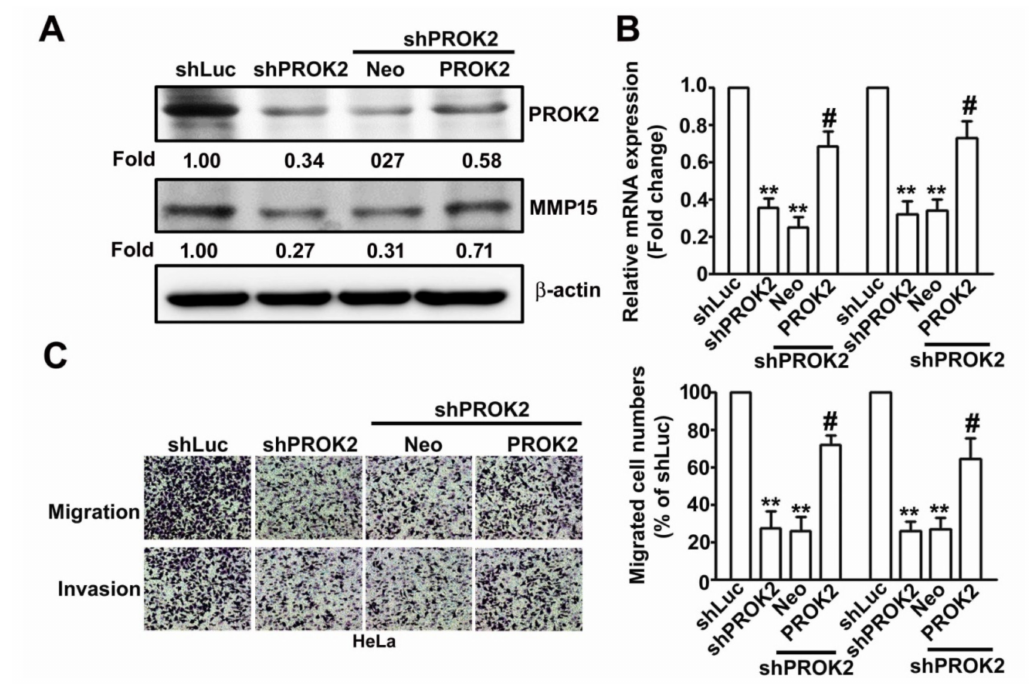
Figure 4. MMP15 involved in PROK2 regulates cell migration and invasion in human cervical cancer HeLa cells. Using transfected with Neo or PROK2 overexpression plasmid in shLuc- or shPROK2-HeLa cells for 48 h. ( A ) The protein expression of MMP15 and PROK2 were measured by the western blotting. β -actin as a protein loading control. ( B ) The MMP15 and PROK2 mRNA expression were detected by RT-qPCR assay. GAPDH as a mRNA loading control. ( C ) In vitro migration and invasion assay was conducted to measures the cell migration and invasion numbers. ** p < 0.01 versus shLuc cells; # p < 0.05 verus shPROK2